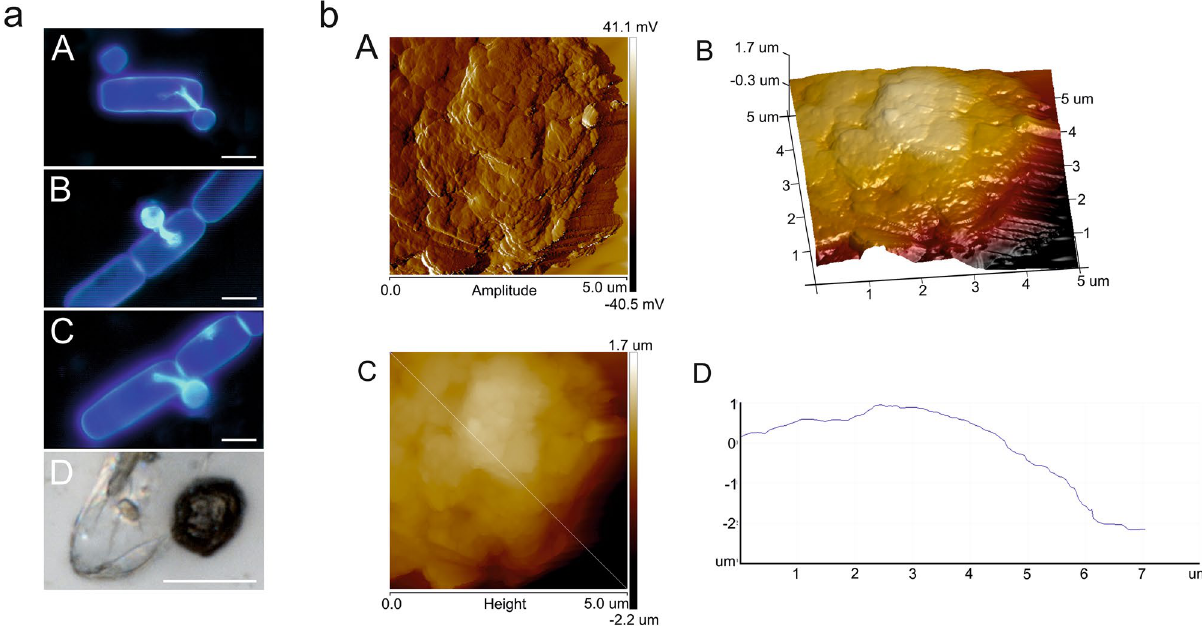
Figure 10. (a) Image of a parasitic fungal cell infecting an A. nordenskioeldii cell. A–C cell visualization after Calcofluor white staining. D—DIC image after SEM preparation. The scale bar corresponds to 5 µm, (b) AFM analysis of fungal cell from image. A—amplitude images of a fragment of the fungal cell surface; B—3D image— right panel; C—height image of the algal cell surface; D—height